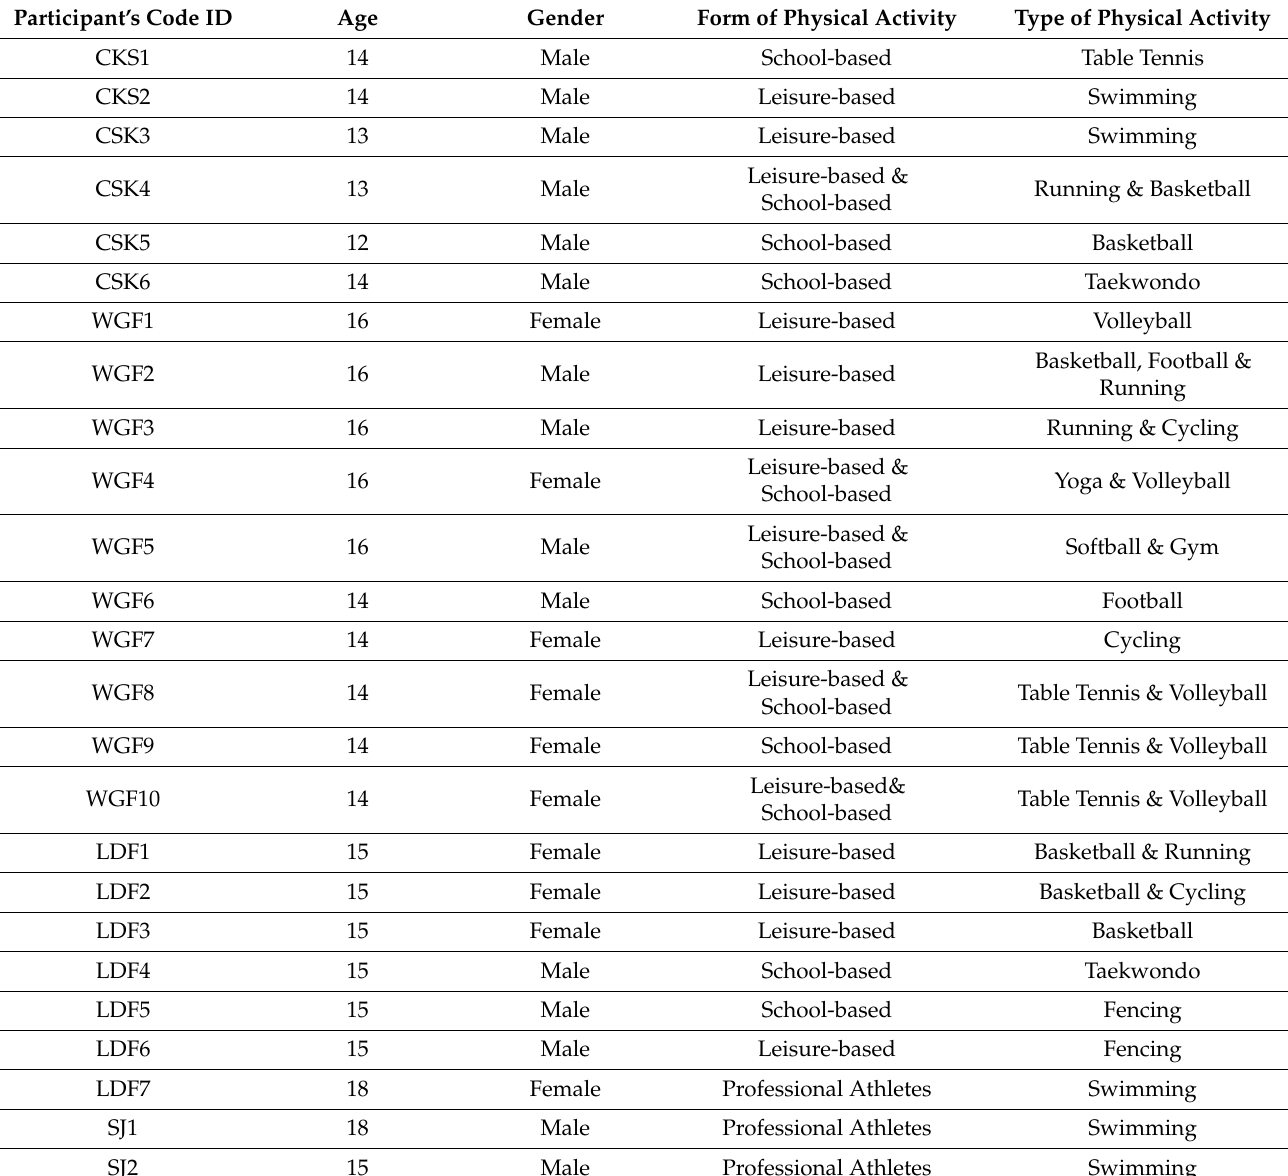
Table 1. Demographic Information of the in-depth